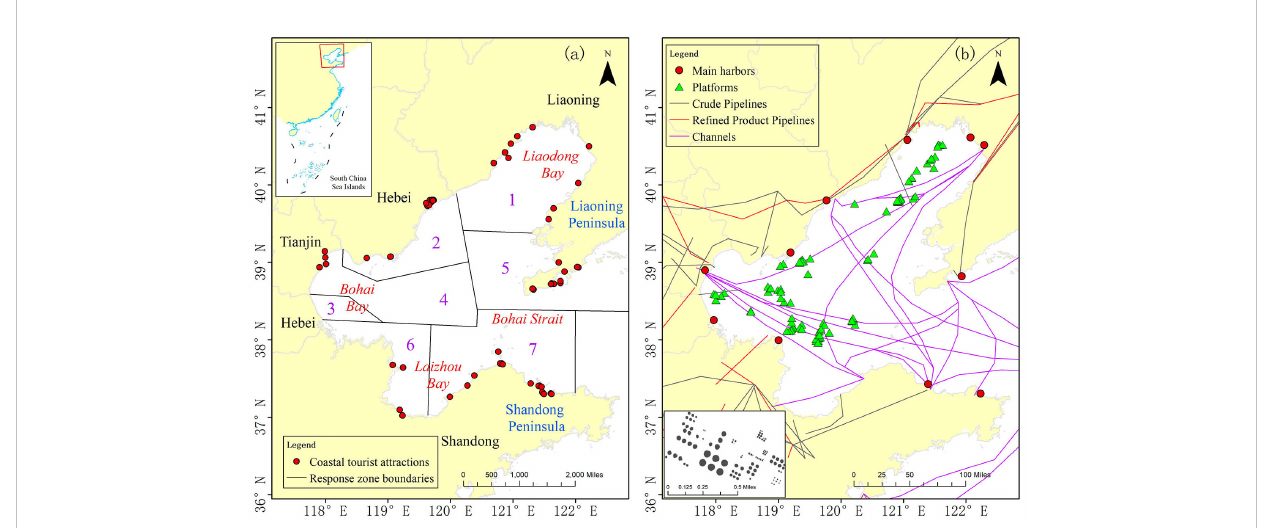
FIGURE 1 (A) Map showing the locations of the Bohai Sea and coastal tourist attractions. (B) The sources of the oil spill risk within and around the Bohai Sea. Some of the selected oil tanks in Tianjin Port are shown in the lower left corner of the image. The amount of ship data information is too large and would cover the other information, so it is not shown